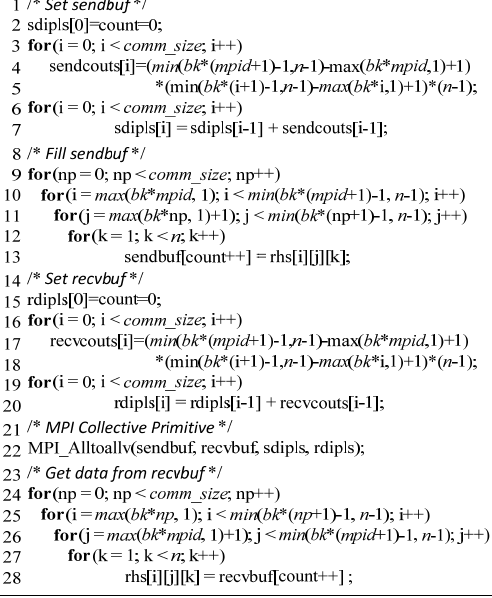
Figure 10. Code of data-reorganization